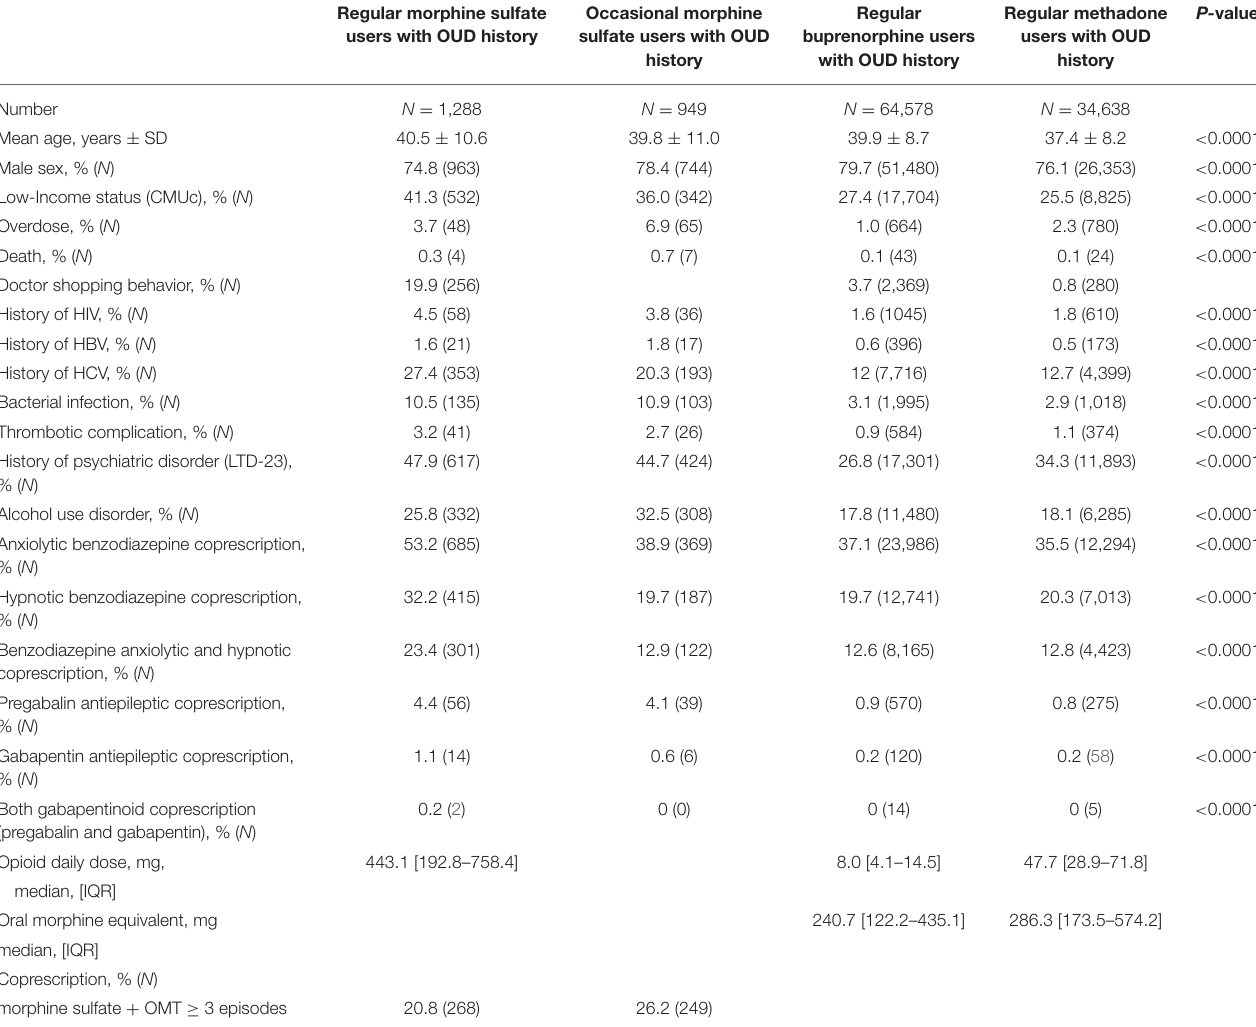
TABLE 1 | Characteristics of patients included in the morphine sulfate and control groups.